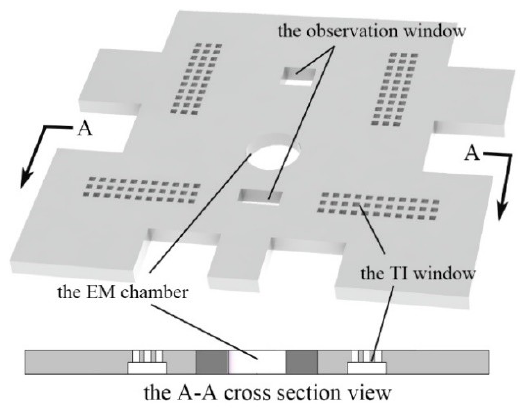
Figure 2. The structure of the cover plate.